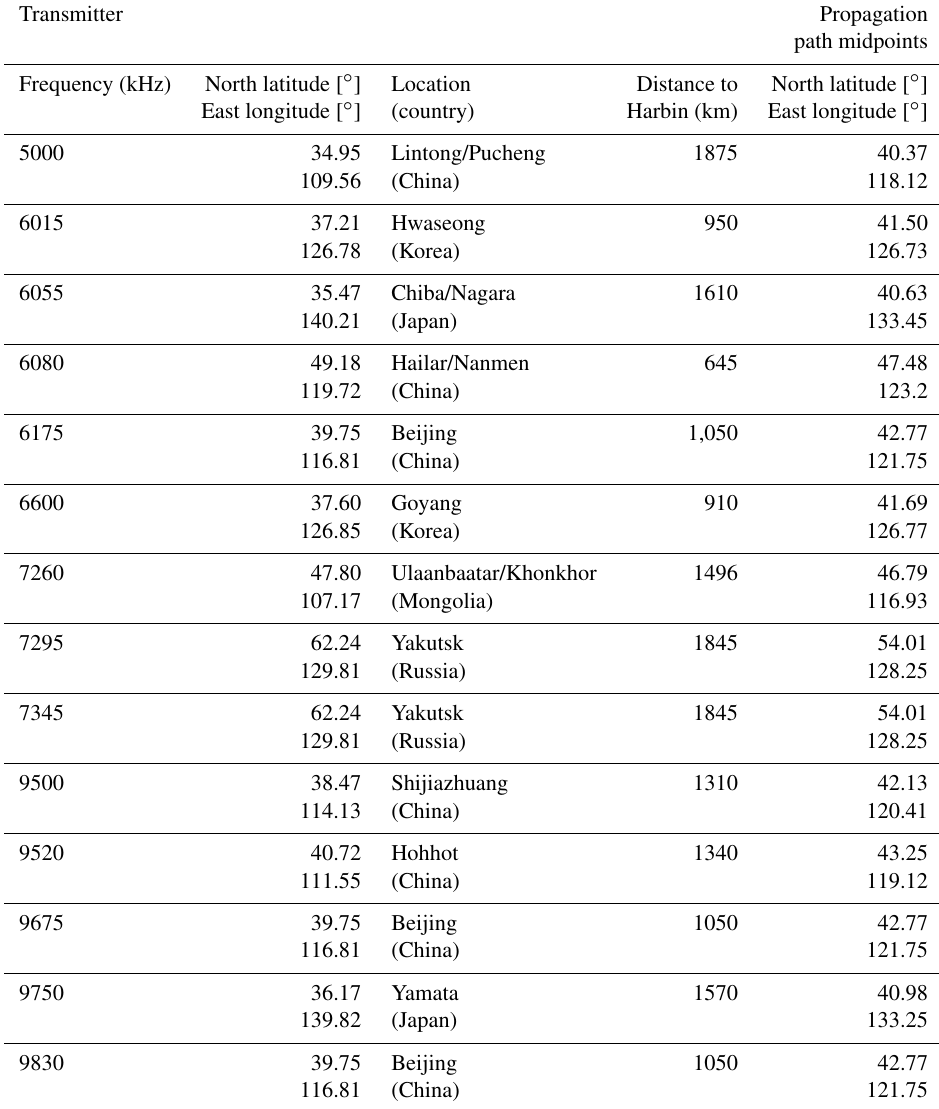
Table 2. Basic parameters of radio paths. Retrieved from https://fmscan.org/index.php, last access: 20 September 2022.